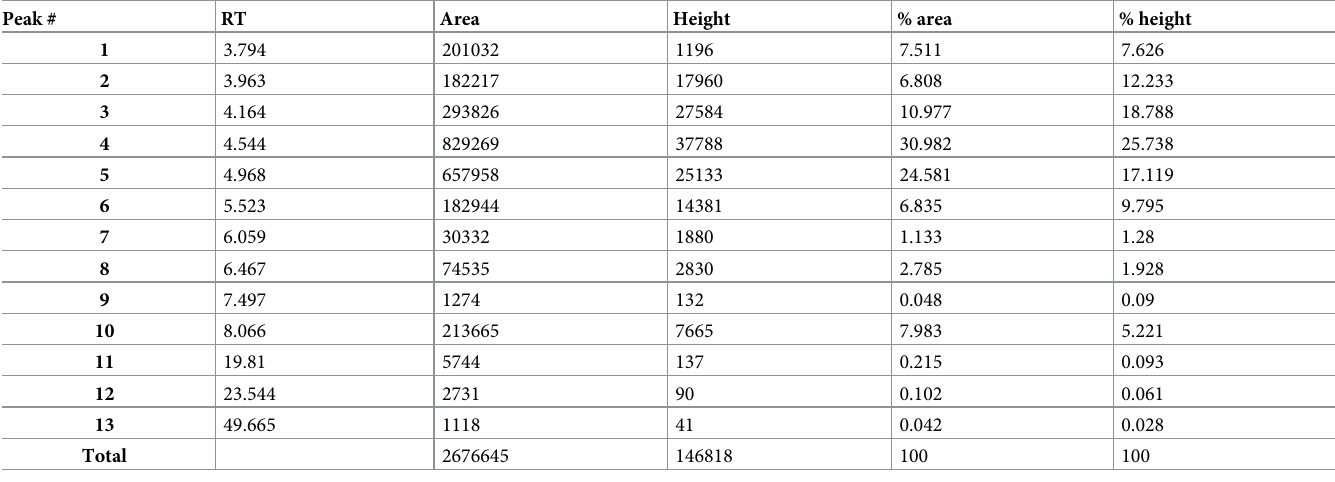
The effect of standardized AEFE on body weight According to Table 7, normal control and the three treatment groups (100, 200, 5 mg/kg) had their weight increased compared to their average baseline weight. However, a comparison of mean weights among these groups at day 14 shows no statistically significant difference (P = 0.578). Conversely, the diabetic control group’s mean body weight on day 14 was lesser than the baseline weight (Table 7). The decrease in body weight could be due to the effect of diseases. Table 5. The HPLC peaks of A . esculentus fruits